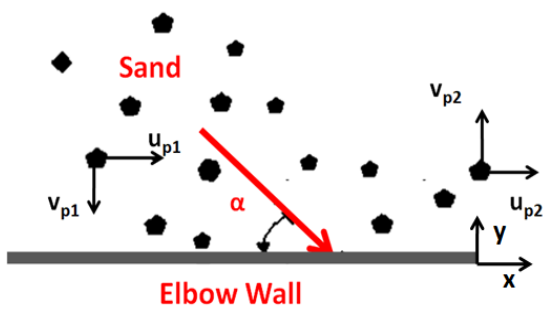
Figure 5. Sand and Elbow wall impact.